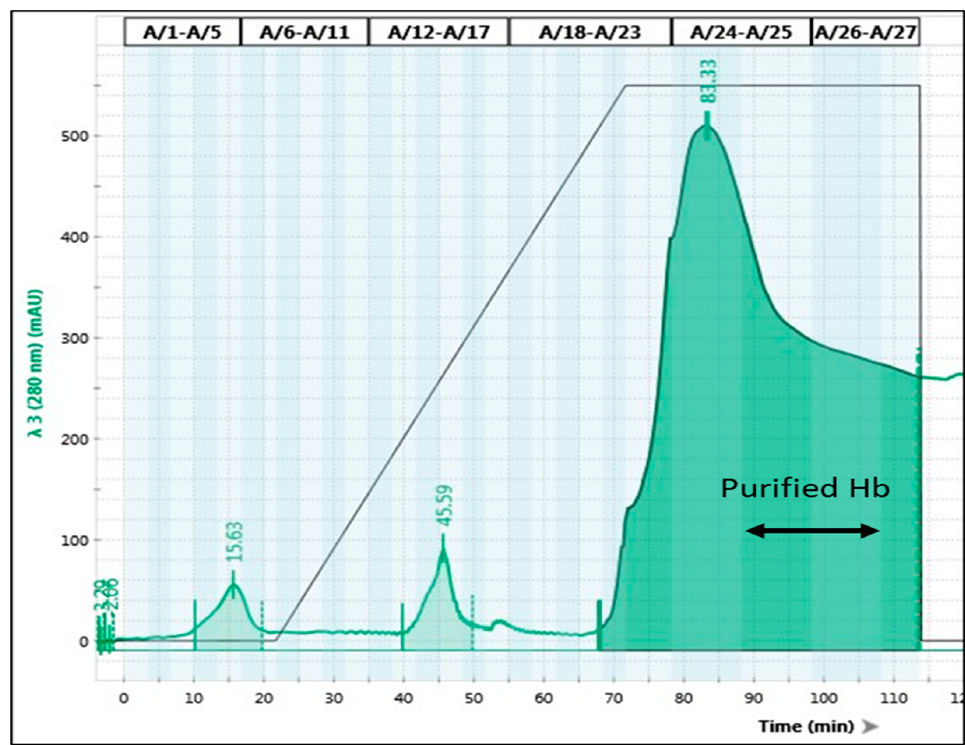
Figure A5. Purification of hemoglobin through anion exchange chromatography. Chromatogram showing purification of hemoglobin. Hemoglobin was eluted after buffer A was completely changed to buffer B, i.e., fractions A22–A26.